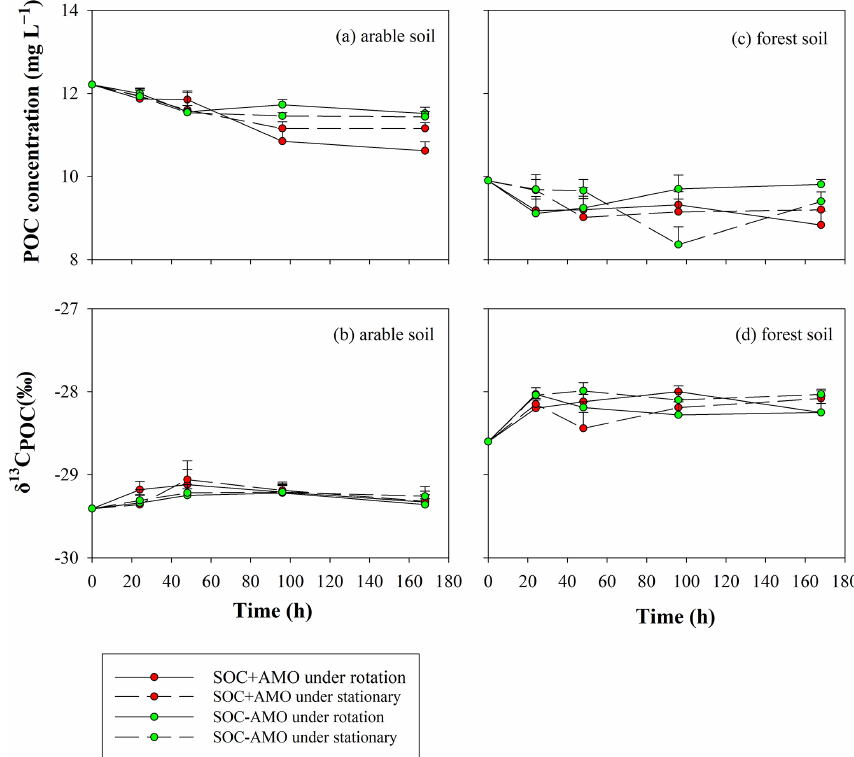
Figure 6. Evolution of POC concentrations and δ 13 C POC values during the incubations for the arable soil ( a, b , respectively) and the forest soil ( c, d ,